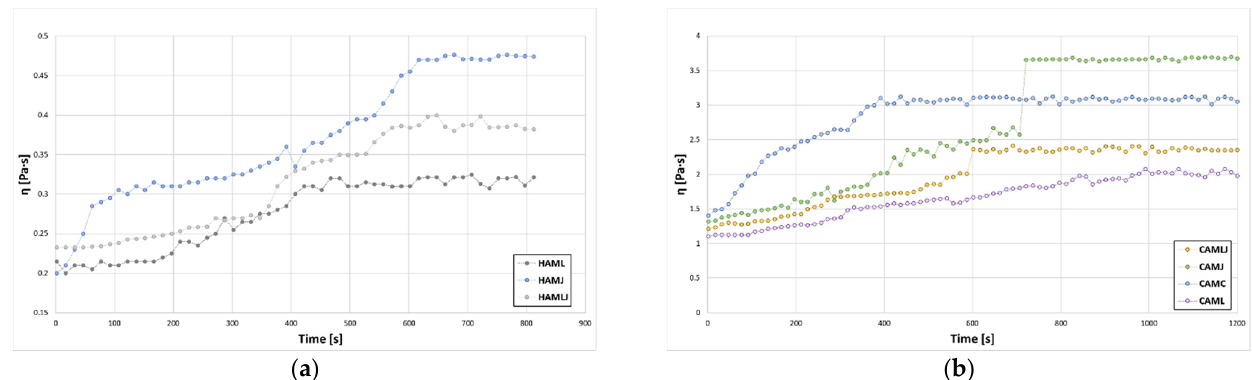
Figure 4. Viscosity vs. blending time: ( a ) hot asphalt mastics and ( b ) cold asphalt mastics.